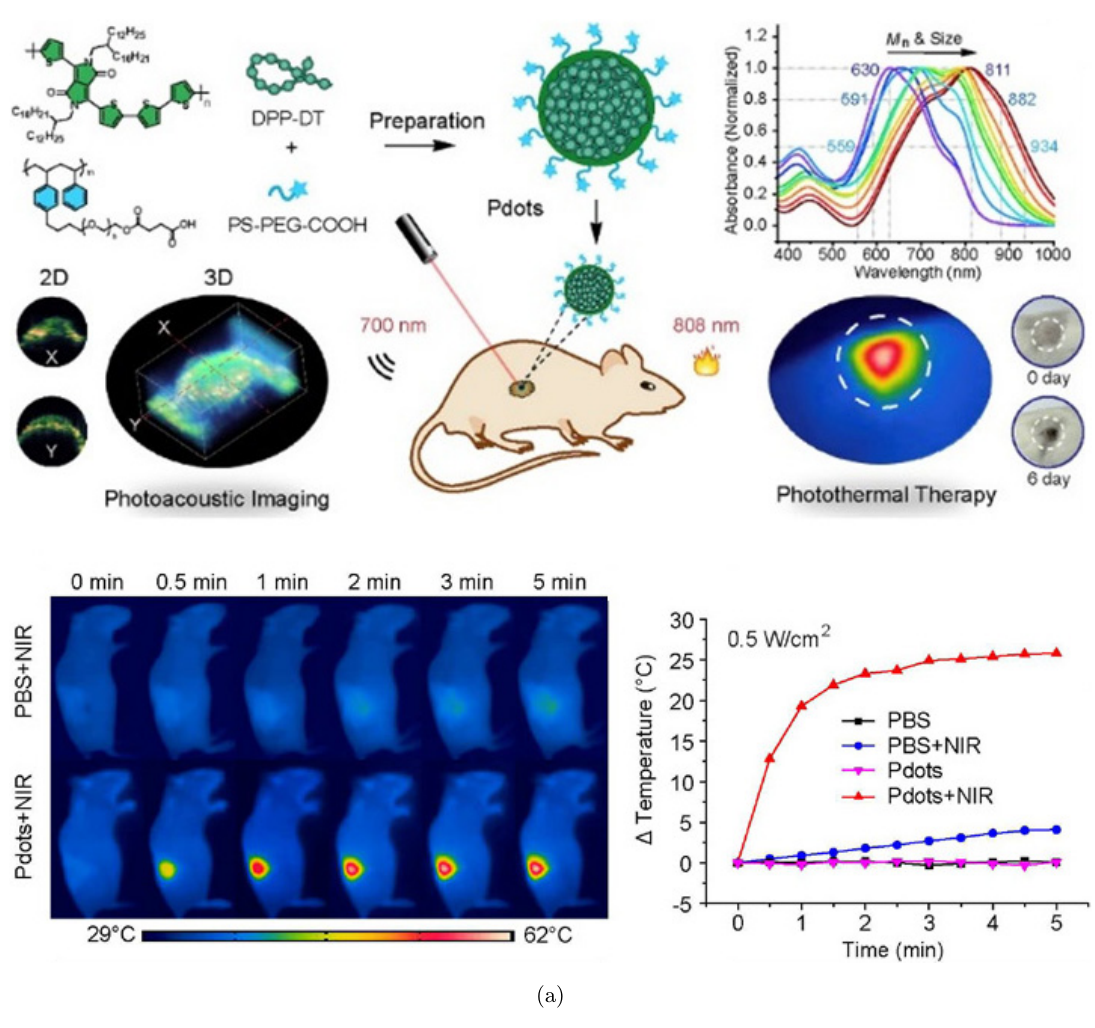
Fig. 5. (a) DPP-DT CPNs as contrast agents for PAI guided PTT. a (b) PAI and PTT of brain tumor.